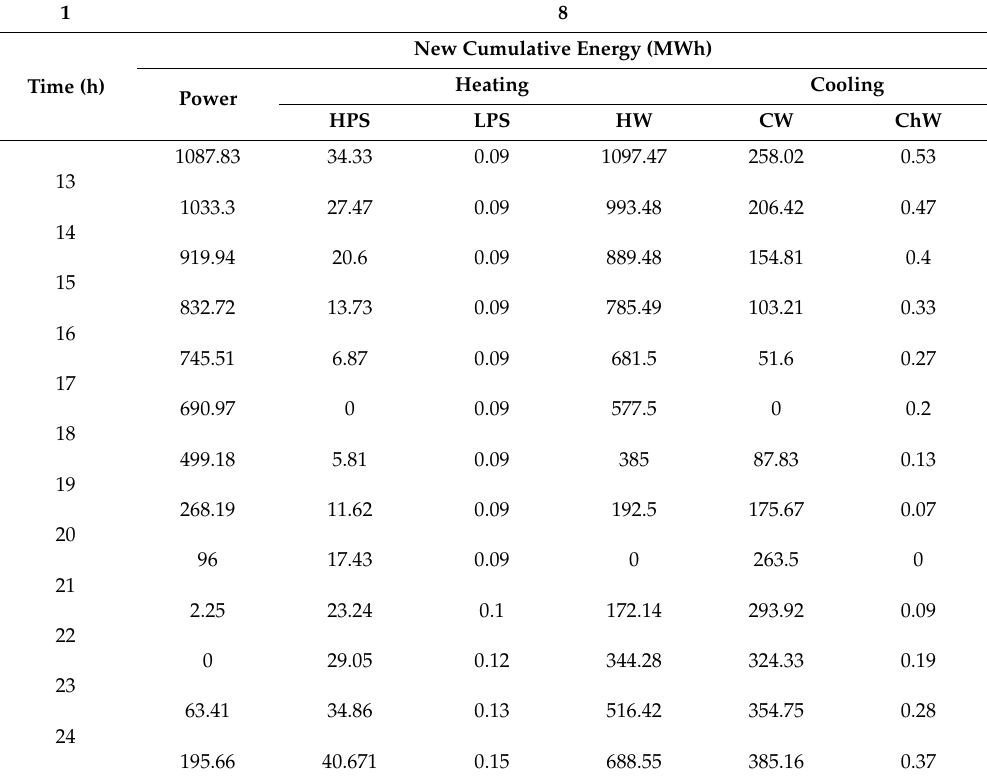
Table A16. TriGenSCA after iteration from 13 to 24